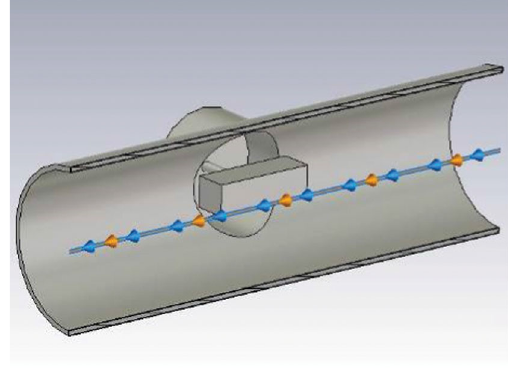
FIG. 3. Half of the 3D collimator model used in the simulation.